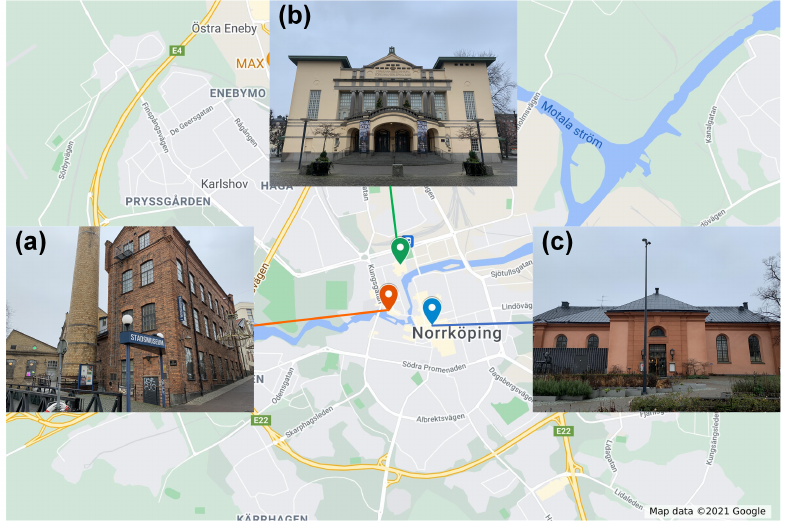
Figure 6. Three historic buildings in Norrköping, Sweden, are chosen as case studies: ( a ) the City Museum, ( b ) the City Theatre, and ( c ) the Auditorium.